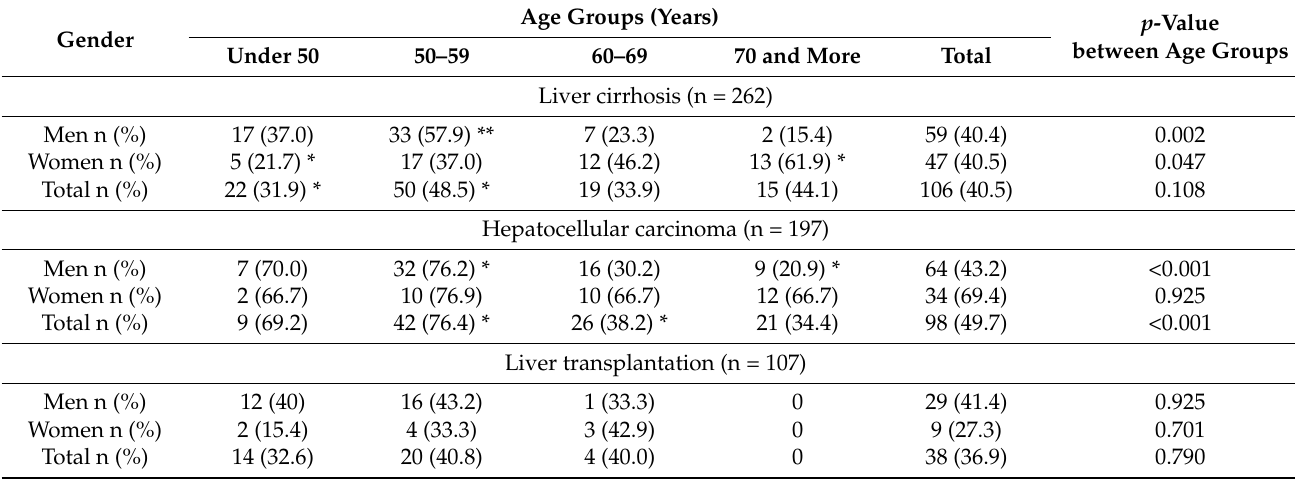
Table 1. Prevalence of chronic hepatitis C virus infection among patients with liver cirrhosis, hep- atocellular carcinoma and liver transplant patients, according to gender and age (data of hospital Kauno